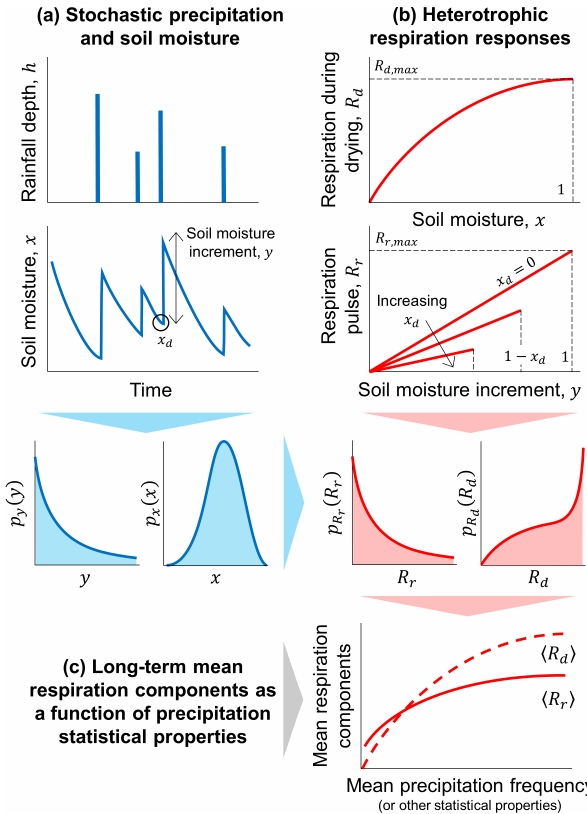
Figure 1. Schematic illustration of the theoretical framework devel- oped to describe how the components of heterotrophic respiration change as a function of rainfall statistical properties. (a) Rainfall is treated as a stochastic process driving random fluctuations in soil moisture, which are captured by the probability density functions (PDF, indicated by p with a subscript for the variable of interest) of soil moisture ( x ) and soil moisture increments ( y ). (b) Respira- tion rate during drying ( R d ) and respiration pulses at rewetting ( R r ) respectively depend on soil moisture and on both soil moisture in- crements and soil moisture at the end of the dry period ( x d ); based on the PDFs of x , y , and x d , the PDFs of the two respiration com- ponents are obtained. (c) Using these PDF of respiration, long-term mean respiration rates during drying ( (cid:104) R d (cid:105) ) and respiration pulses ( (cid:104) R r (cid:105) ) are calculated, and their relations with the statistical proper- ties of precipitation are